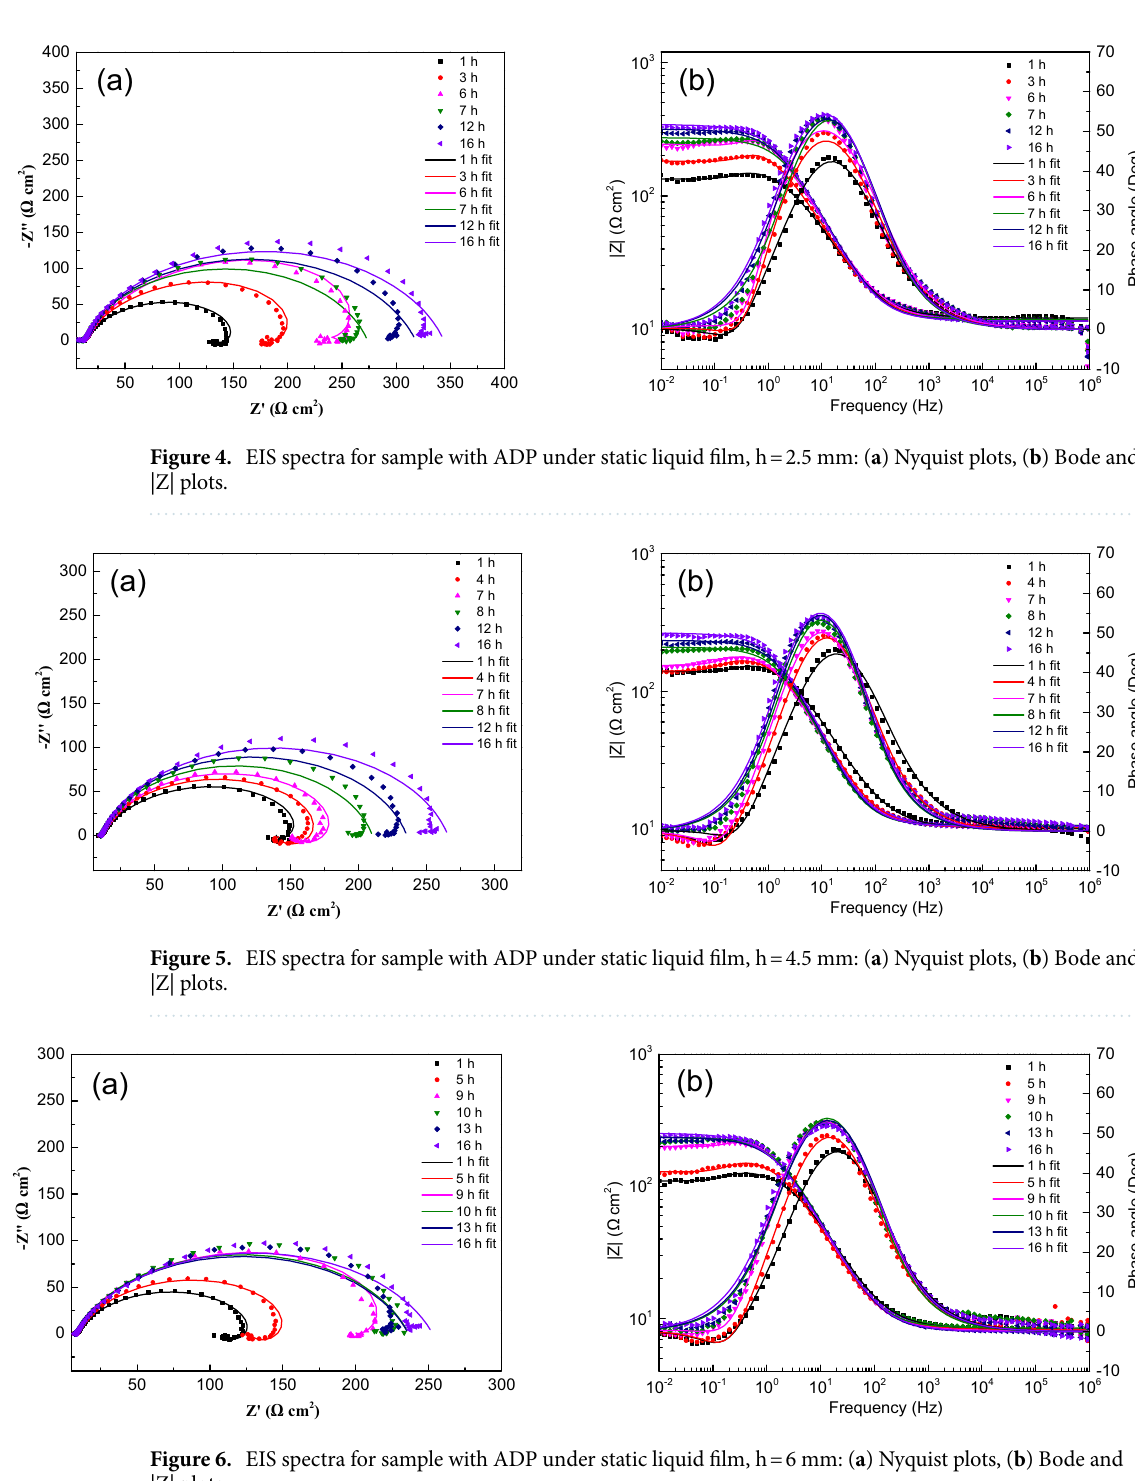
Figure 6. EIS spectra for sample with ADP under static liquid film, h = 6 mm: ( a ) Nyquist plots, ( b ) Bode and |Z|